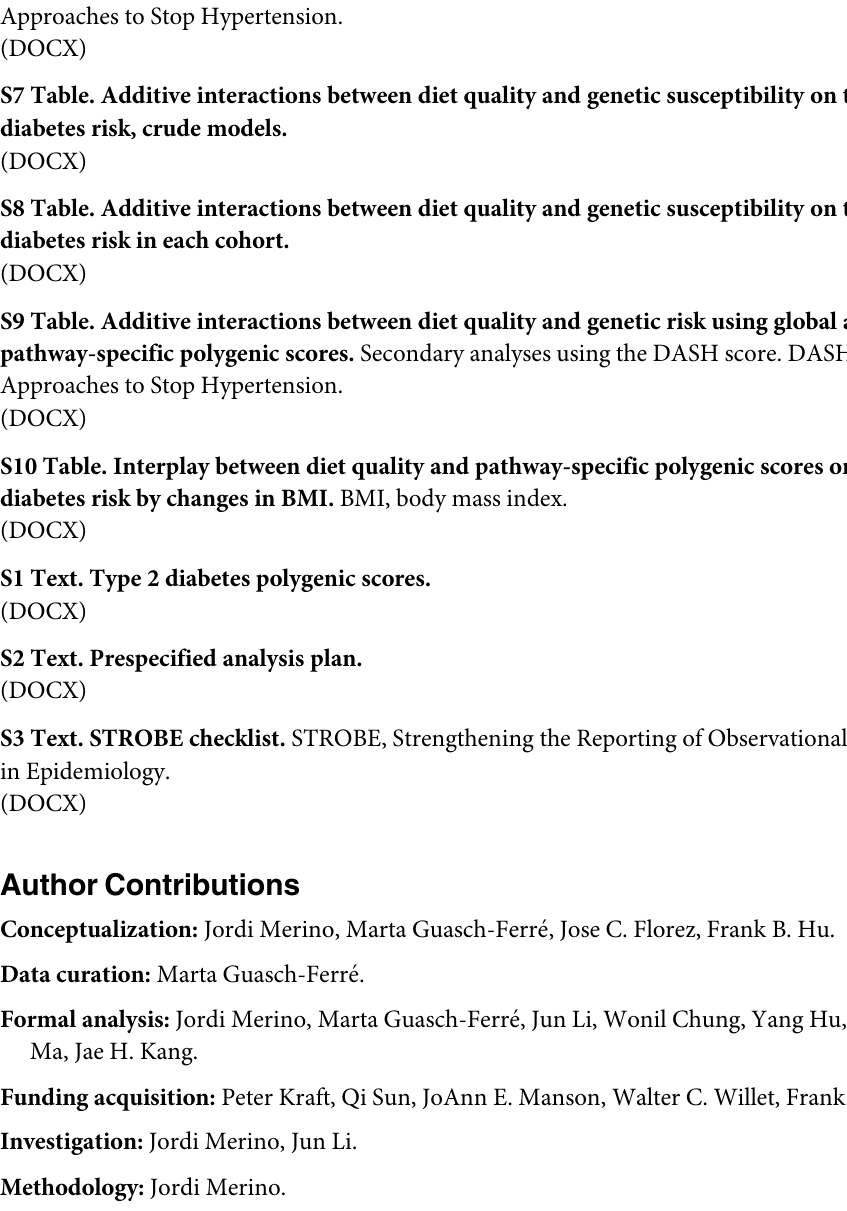
S5 Table. Associations of global and process-specific polygenic scores with type 2 diabetes risk, random-effects meta-analysis. S6 Table. Multiplicative interactions between diet quality and genetic risk using global and pathway-specific polygenic scores. Secondary analyses using the DASH score. DASH, Dietary Approaches to Stop Hypertension. S7 Table. Additive interactions between diet quality and genetic susceptibility on type 2 diabetes risk, crude models. S8 Table. Additive interactions between diet quality and genetic susceptibility on type 2 diabetes risk in each cohort. S9 Table. Additive interactions between diet quality and genetic risk using global and pathway-specific polygenic scores. Secondary analyses using the DASH score. DASH, Dietary Approaches to Stop Hypertension. S10 Table. Interplay between diet quality and pathway-specific polygenic scores on type 2 diabetes risk by changes in BMI. BMI, body mass